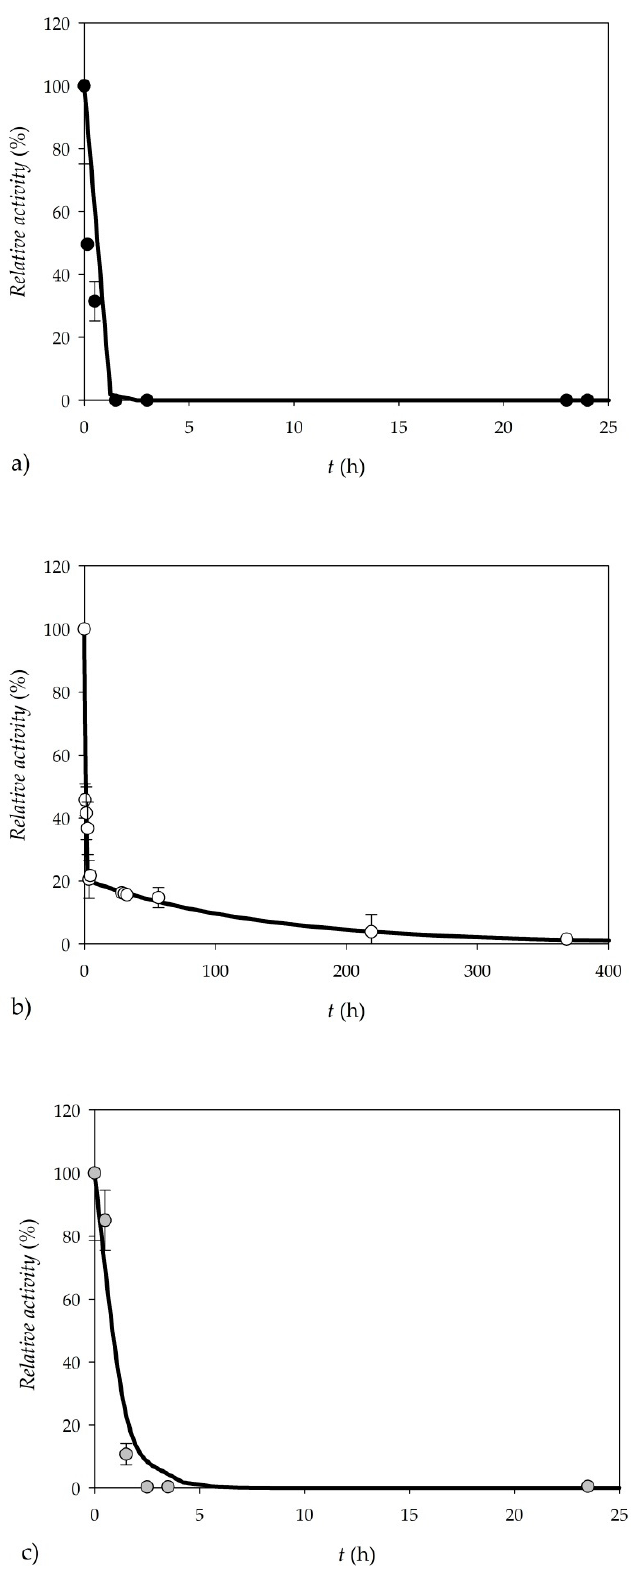
Figure 5. Investigation of enzyme stability in an oil/methanol reaction mixture ( V reactor = 400 cm 3 , n = 300 rpm, T = 40 °C, t = 368 h) for ( a ) commercial, ( b ) unpurified, and ( c ) purified enzyme ( ▬ mathematical model) .